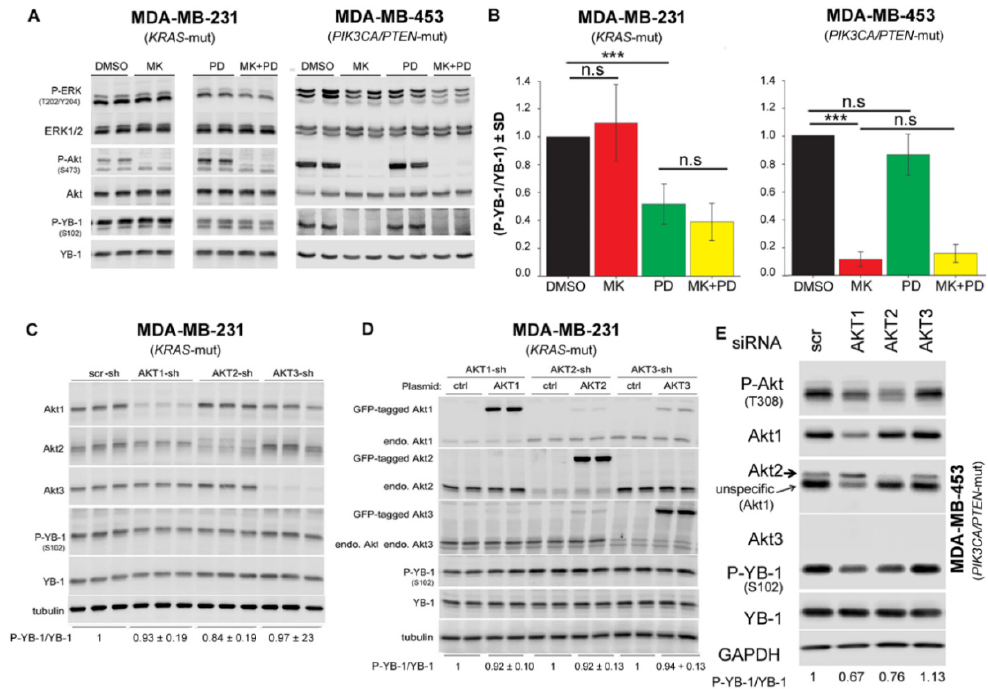
Figure 3. Akt differentially affects S102 phosphorylation of YB-1 in PTEN wild-type vs. PTEN mutated cells. ( A ) The indicated cells were treated with the Akt inhibitor MK2206 (MK, 10 µM), PD98059 (PD, 20 µM), or a combination of MK and PD for 2 h. Control cells received DMSO. Protein samples were isolated, and the indicated proteins were detected by Western blotting. Protein samples exposed to the same treatment conditions were isolated from 2 parallel cultures, and the results are shown in the panel. ( B ) Densitometry values represent the mean P-YB-1/YB-1 ratio normalized to 1 in DMSO treated condition (MDA-MB-231: n = 7 data from 3 independent experiments; MDA-MB-453: n = 4 data from 3 independent experiments). (*** p < 0.001, Student’s t -test), n.s.: not significant. ( C ) Protein samples were isolated from MDA-MB-231 cells stably transfected with scrambled-shRNA (scr-sh), Akt1-shRNA, Akt2-shRNA, or Akt3-shRNA. Protein samples were isolated from three parallel cultures. ( D ) MDA-MB-231 cells stably expressing shRNA against endogenous Akt1, Akt2, or Akt3 were transiently transfected with plasmid expressing eGFP-tagged-Akt1, -Akt2, or -Akt3. Forty-eight hours after transfection, protein samples were isolated from two parallel cultures. ( E ) Cells were transfected with 50 nM of indicated siRNA, and protein samples were isolated after 48 h. Levels of phosphorylation and expression of indicated proteins were analyzed by Western blotting. Following detection of phospho-proteins, blots were stripped and re-incubated to detect total proteins. GAPDH was used as loading control.